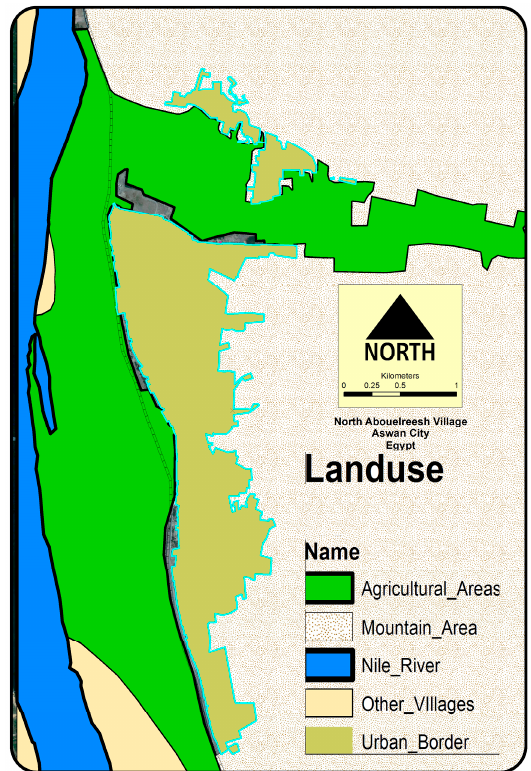
Figure 6. A map showing the current status of the land use in and around the village of Abouelreesh.